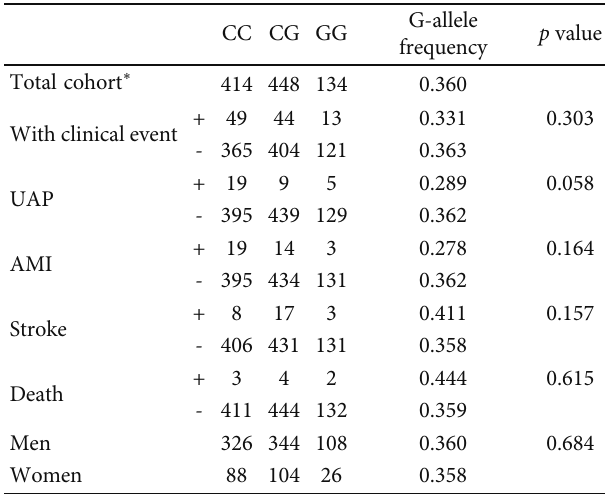
Table 2: Frequency of the NLRP3 variant in the total population and according to type of new clinical events and sex.